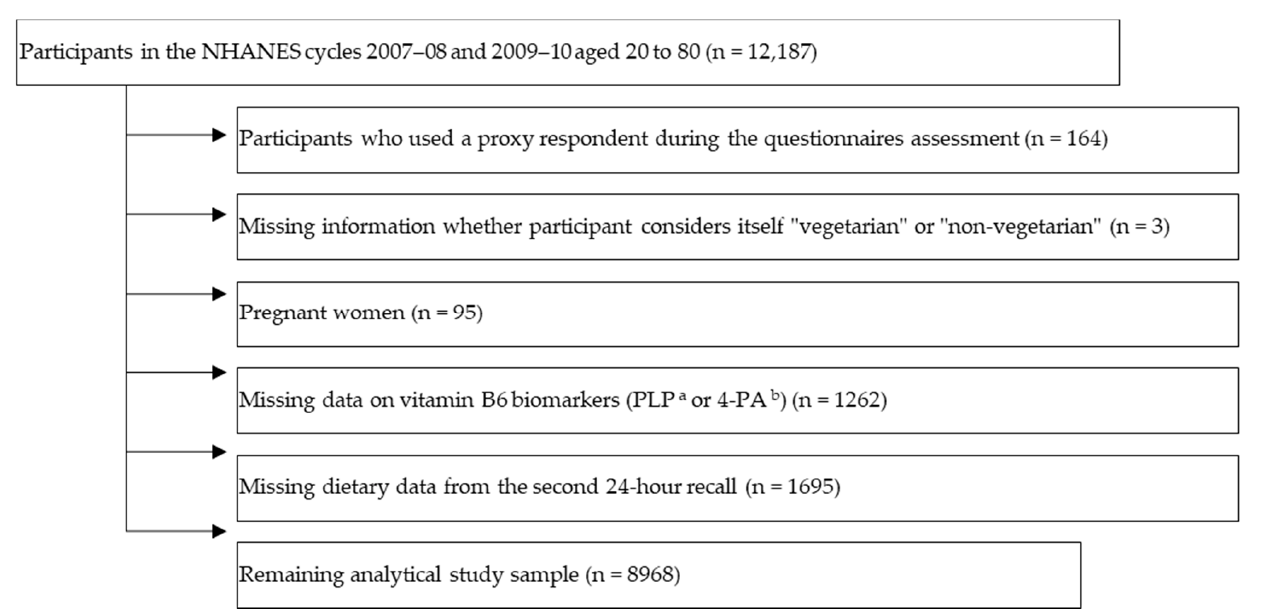
Figure A1. Characteristics and exclusion of study population. a Pyridoxal-5 ′ -Phosphate; b 4-Pyridoxic Acid. Table A1. Survey-weighted food group consumption of NHANES 2007–2010 study participants following a meat-eating, flexitarian, pescatarian or vegetarian diet.